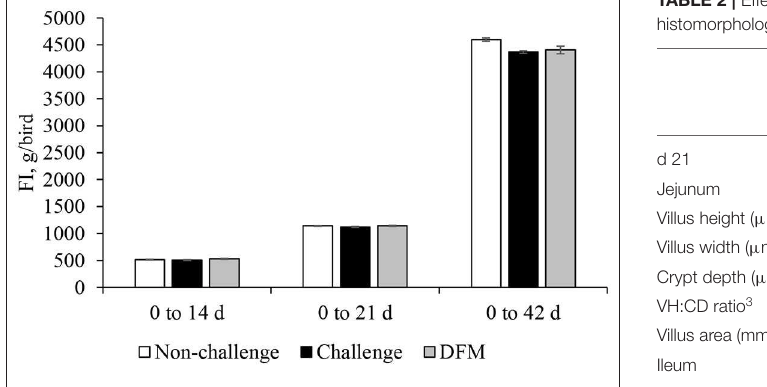
FIGURE 2 | Feed intake (FI) of broiler chickens fed control and treatment diets. Each bar represents the mean ± SE ( n = 7).